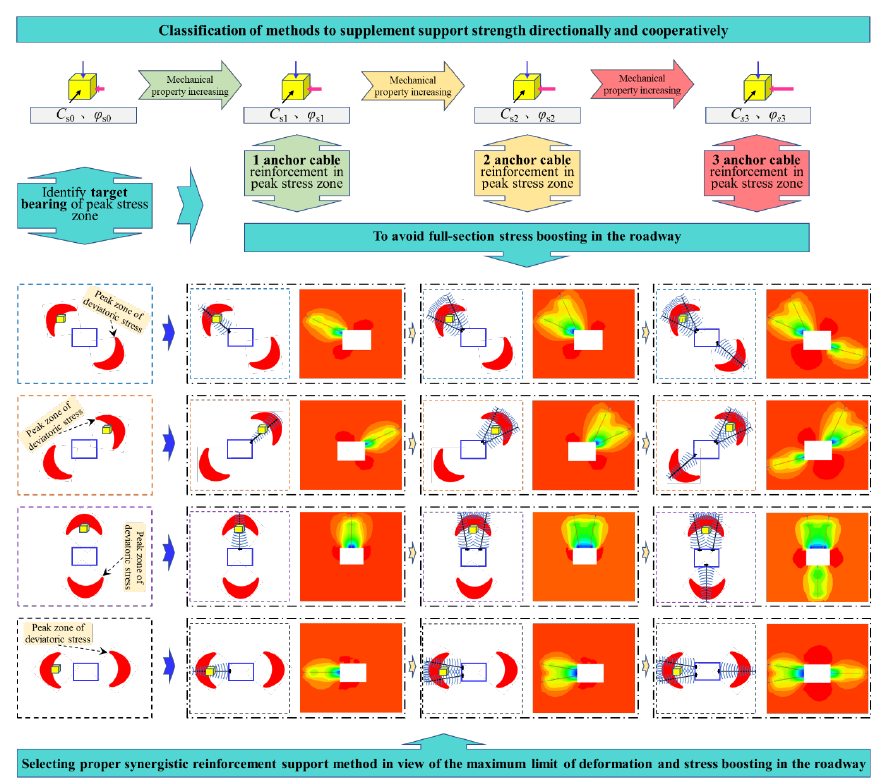
Figure 14. Principle of the directional cooperative anchoring in the roadway.